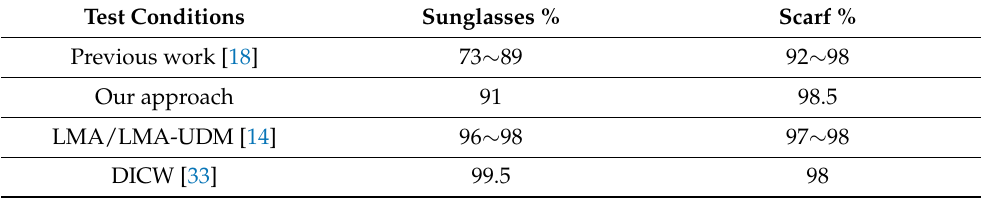
Table 1. Comparing Random Patching approach results on the AR dataset to the